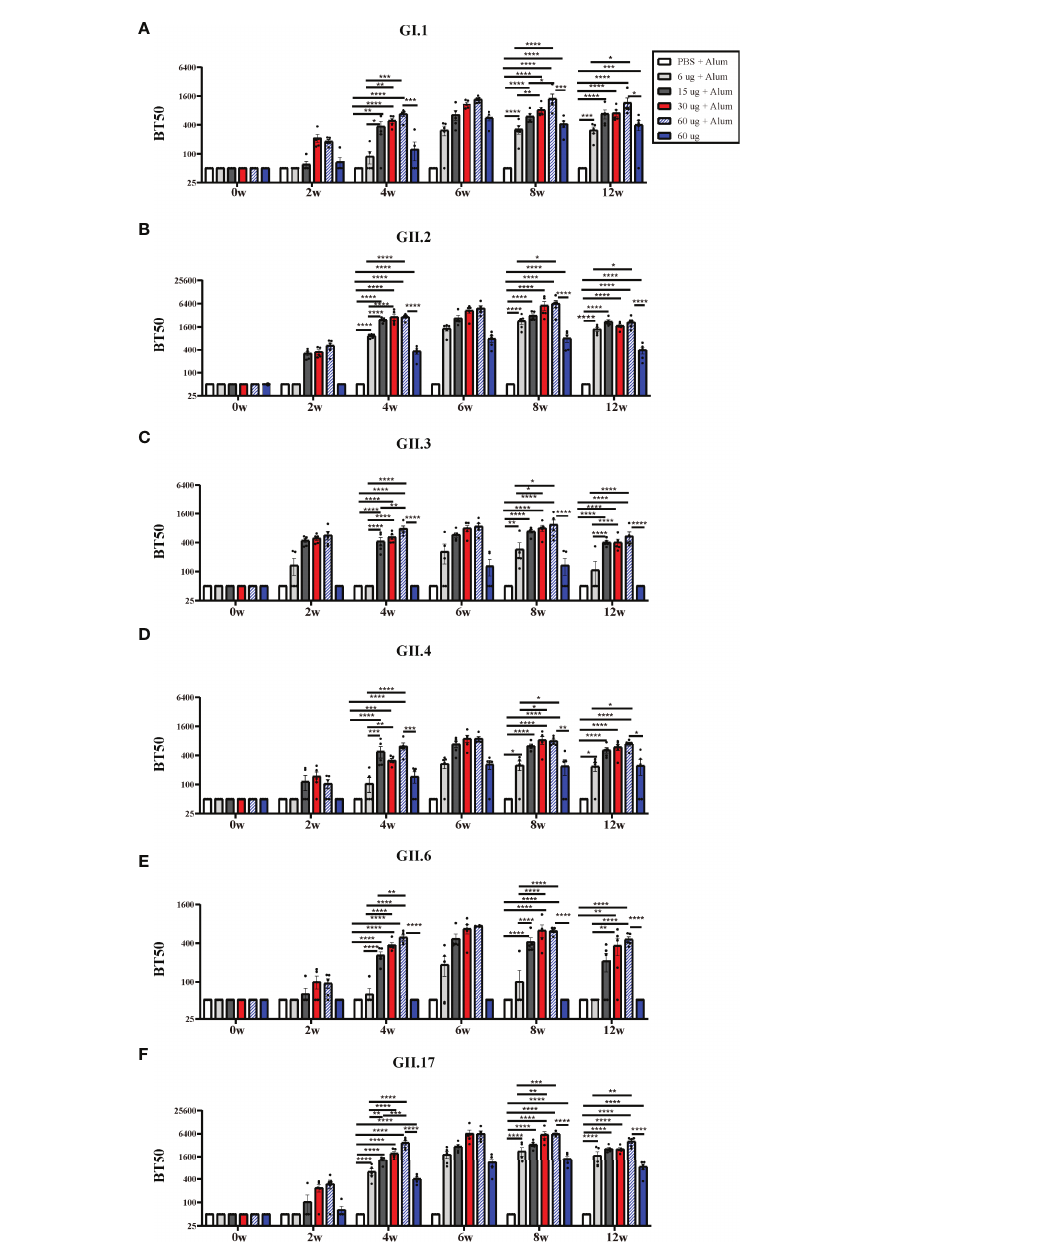
FIGURE 3 | NoV genotype-speci fi c blockade antibody responses induced by diverse Hexa-VLPs dosage. Individual mouse sera were analyzed for blockade antibody titers using the VLP-mucin binding blockade assay. Blockade antibody against (A) GI.1, (B) GII.2, (C) GII.3, (D) GII.4, (E) GII.6 and (F) GII.17 VLPs were detected via ELISA. Blocking titer 50 (BT50) was expressed as the reciprocal of the highest serum dilution blocking 50% of the maximum VLP binding. An arbitrary titer, BT50 of 50, was assigned to samples with <50% blocking index at the lowest serum dilution of 1:100. All data were shown as means ± SEM. Statistical differences at 4 w, 8 w, 12 w were analyzed using one-way ANOVA test with Tukey correction for multiple testing. p < 0.05 (*) was considered statistically signi fi cant; p < 0.01(**); p < 0.001(***); p <